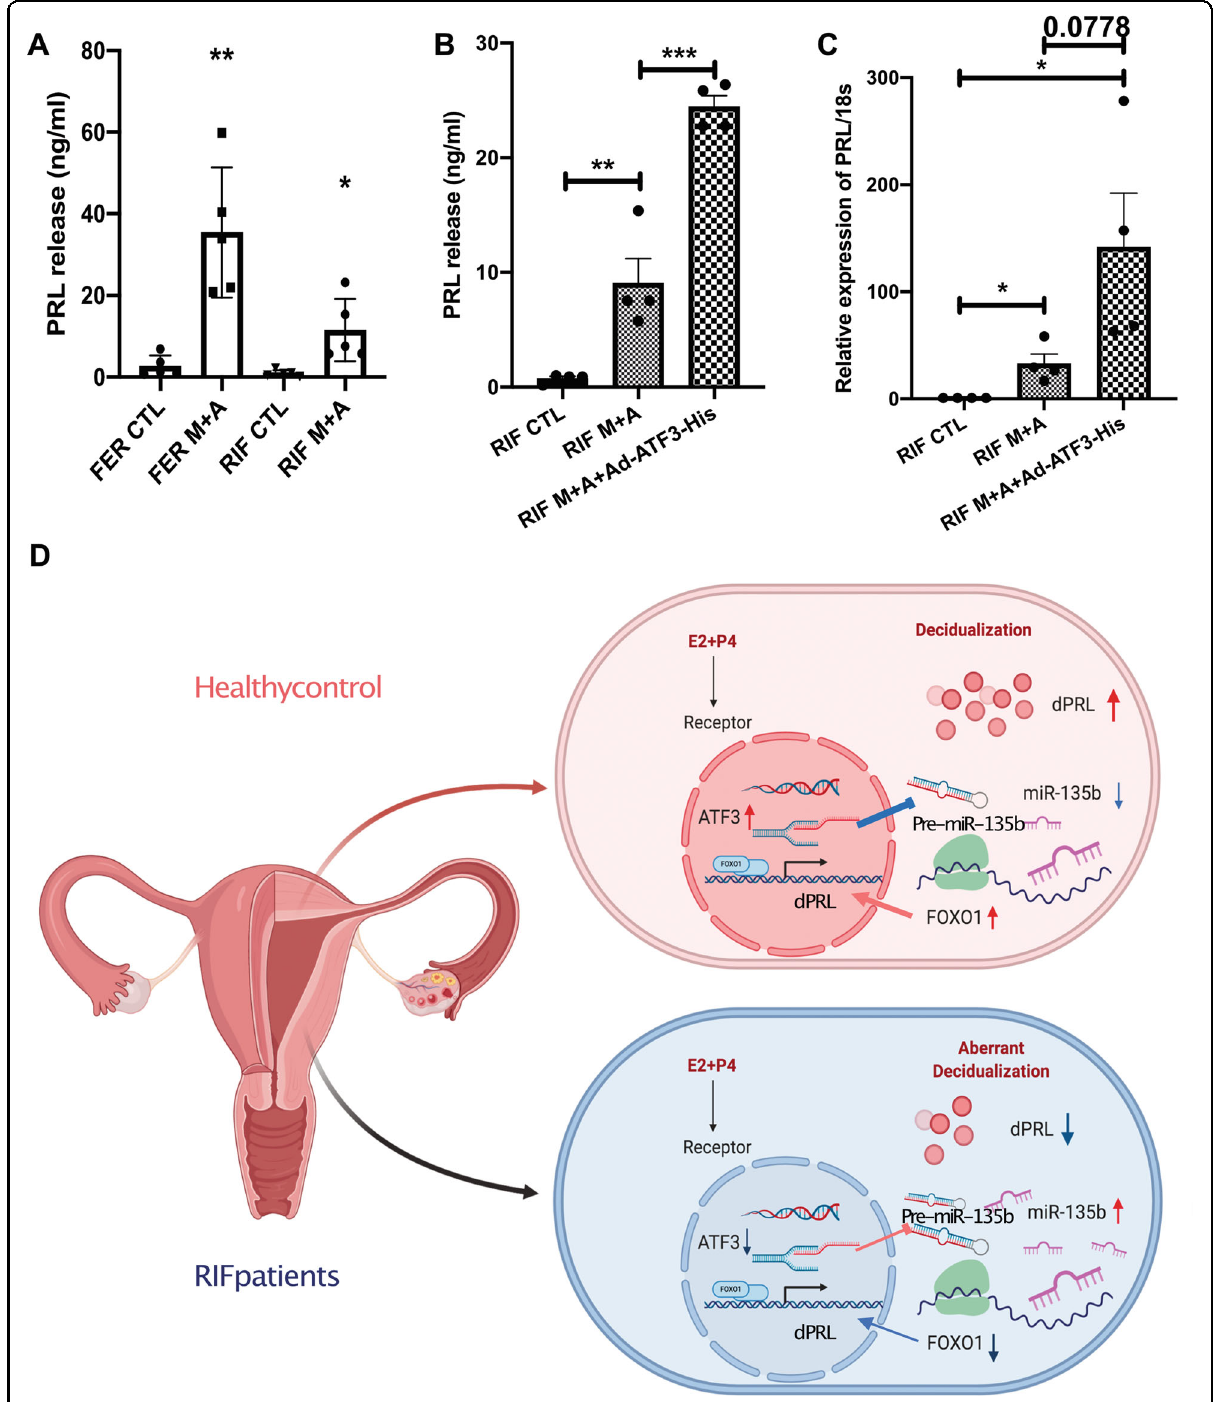
Fig. 7 Decidualization is augmented by overexpression of ATF3 in RIF patients. A hESCs (from fertile controls and RIF patients) were treated with 8-Br-cAMP + MPA for 3 days. Prolactin secretion was measured by ELFA. n = 5, * P < 0.05, ** P < 0.01. B , C hESCs from RIF patients were infected with Ad-ATF3-his (0 or 40 MOI) or Ad-LacZ for 48 h followed by treatment with 0.5 mM 8-Br-cAMP and 1 μ M MPA for 3 days. Prolactin released into the medium was measured by ELFA and qPCR. n = 4, * P < 0.05, ** P < 0.01. D Schematic representation of the role of ATF3 in the regulation of decidualization in RIF patients and fertile control